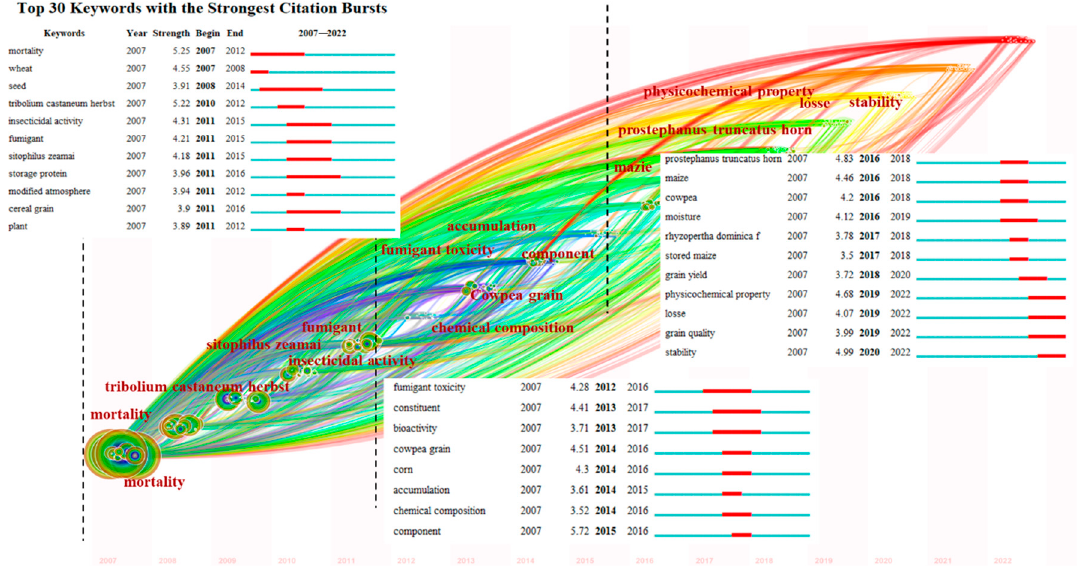
Figure 7. Top 30 burst keywords detection.